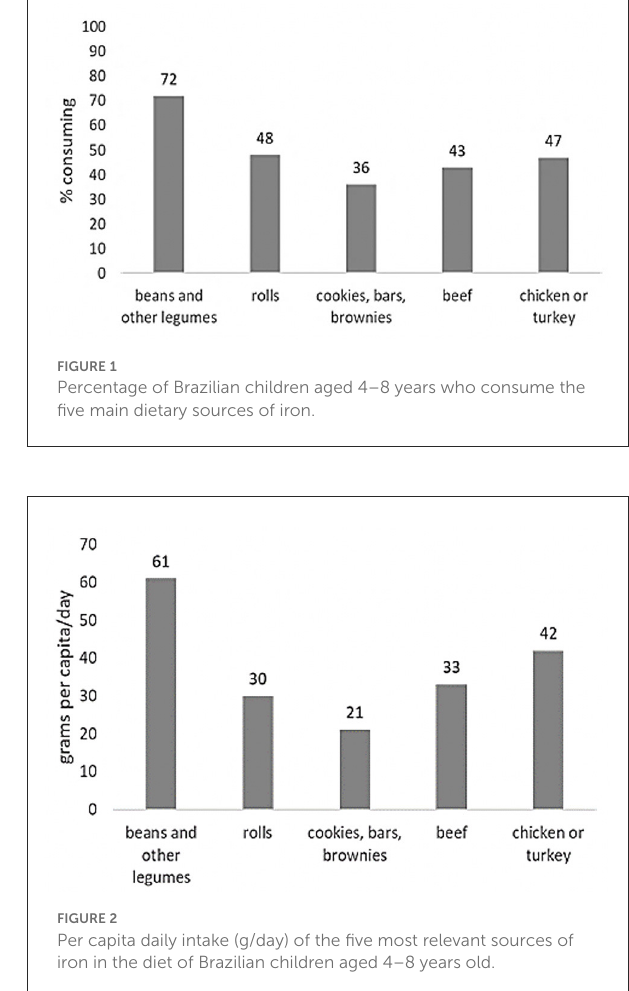
iron) and the low meat consumption (high iron bioavailability) contribute significantly for iron deficiency establishment (6, 8, 10, 27, 30–32,